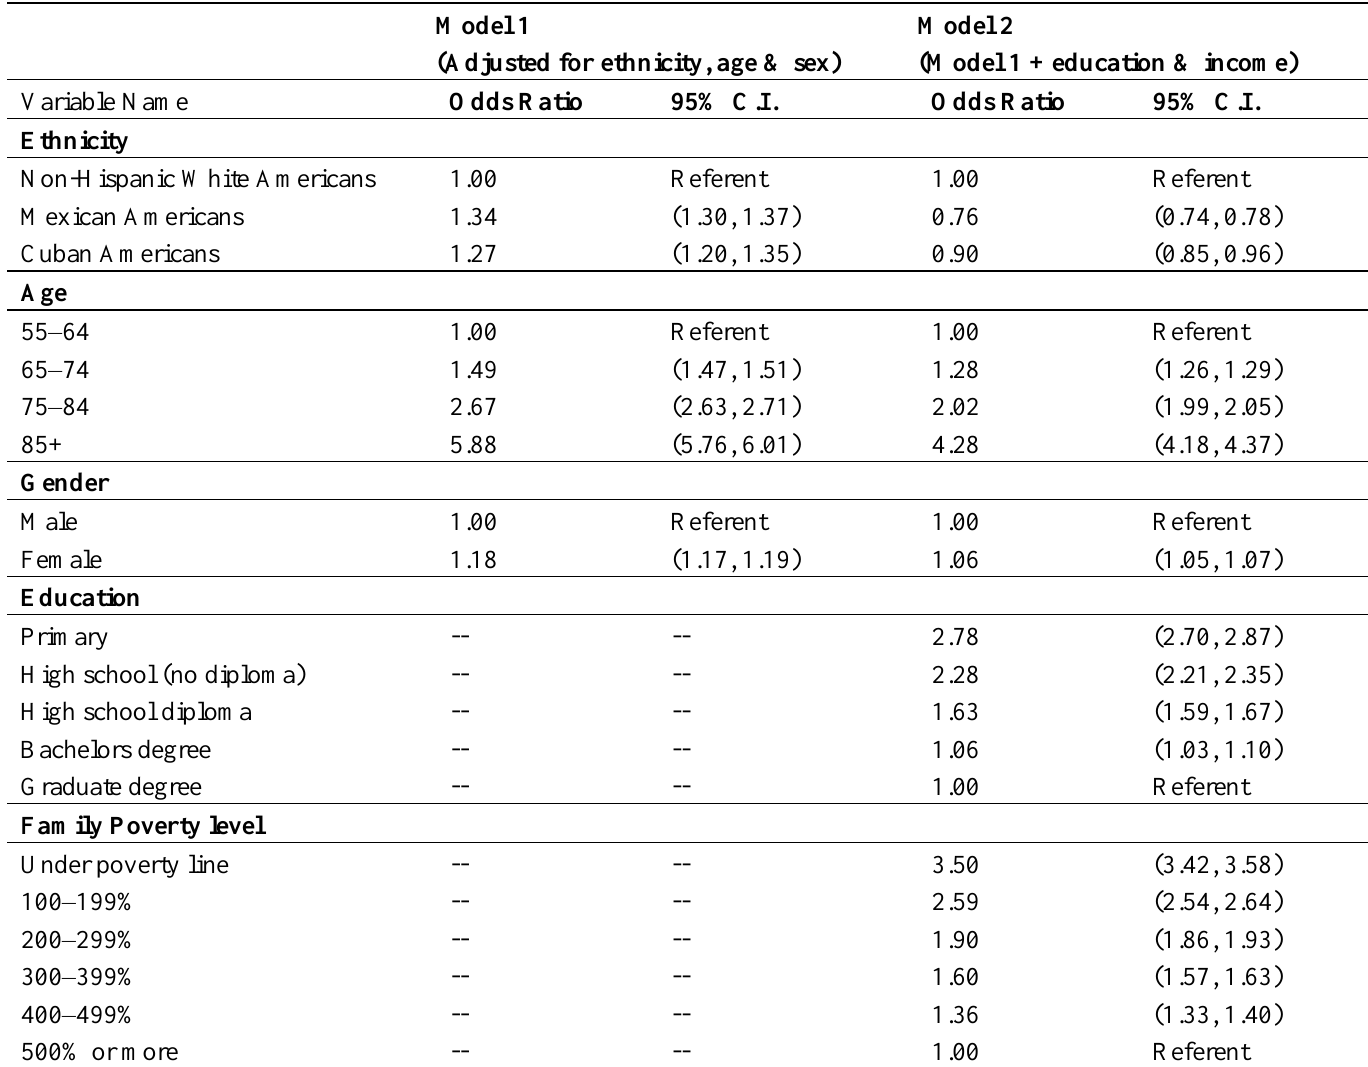
Table 2. Logistic regression analyses of functional limitations status by ethnicity (irrespective of immigrant status) for individuals aged 55 and